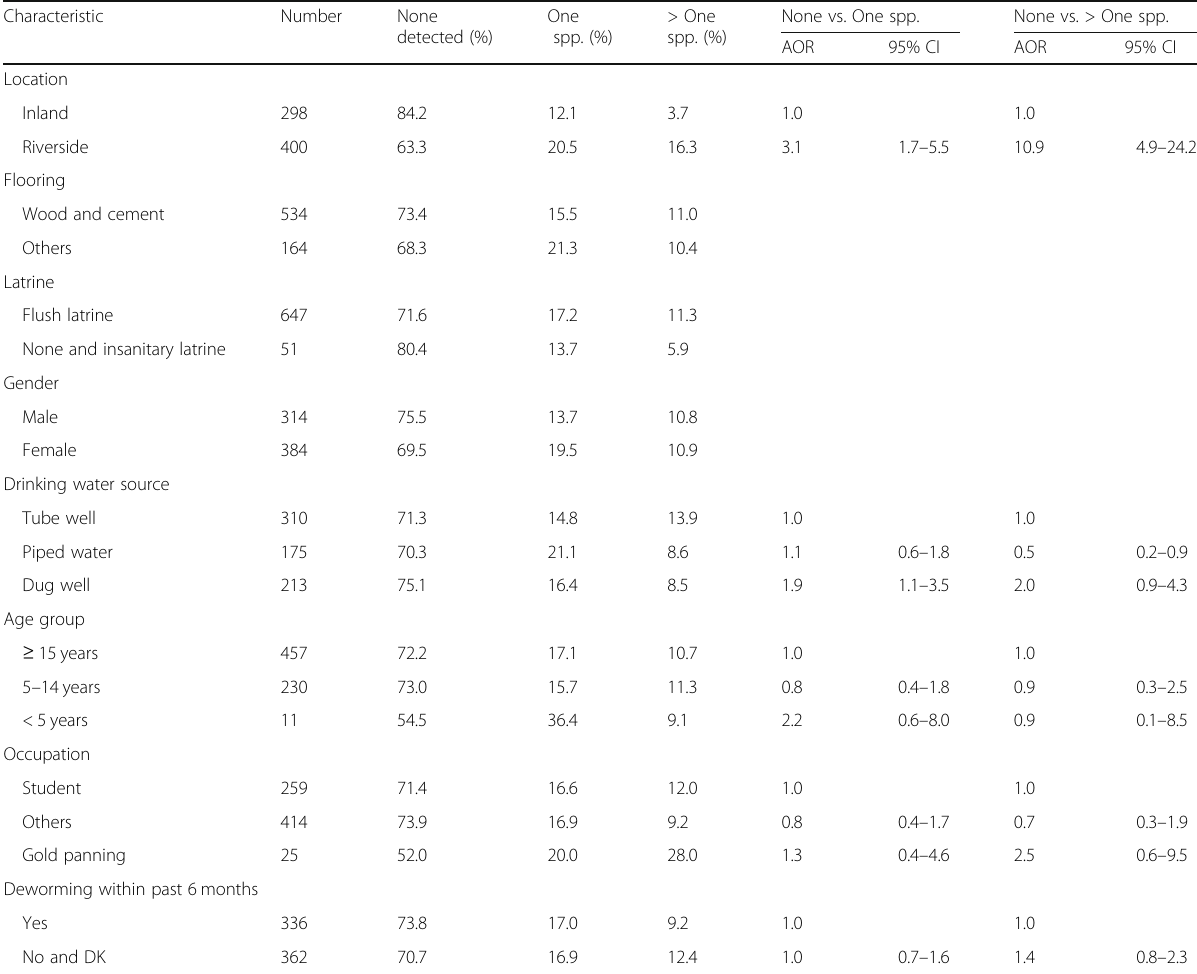
Table 3 Helminths infections and associated factors in Shwegyin Township, Myanmar, 2017 ( n = 698) Characteristic